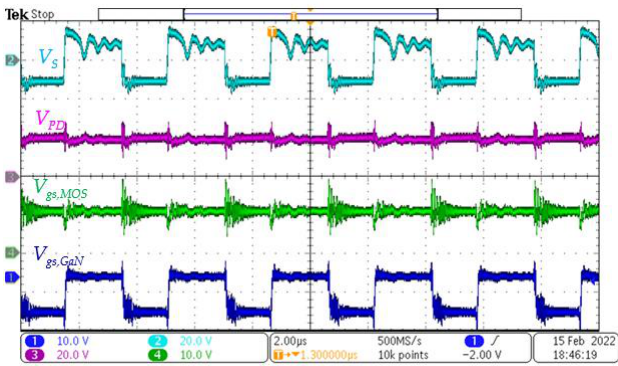
Figure 13. Voltage responses of the D-mode GaN HEMT synchronous rectifier.